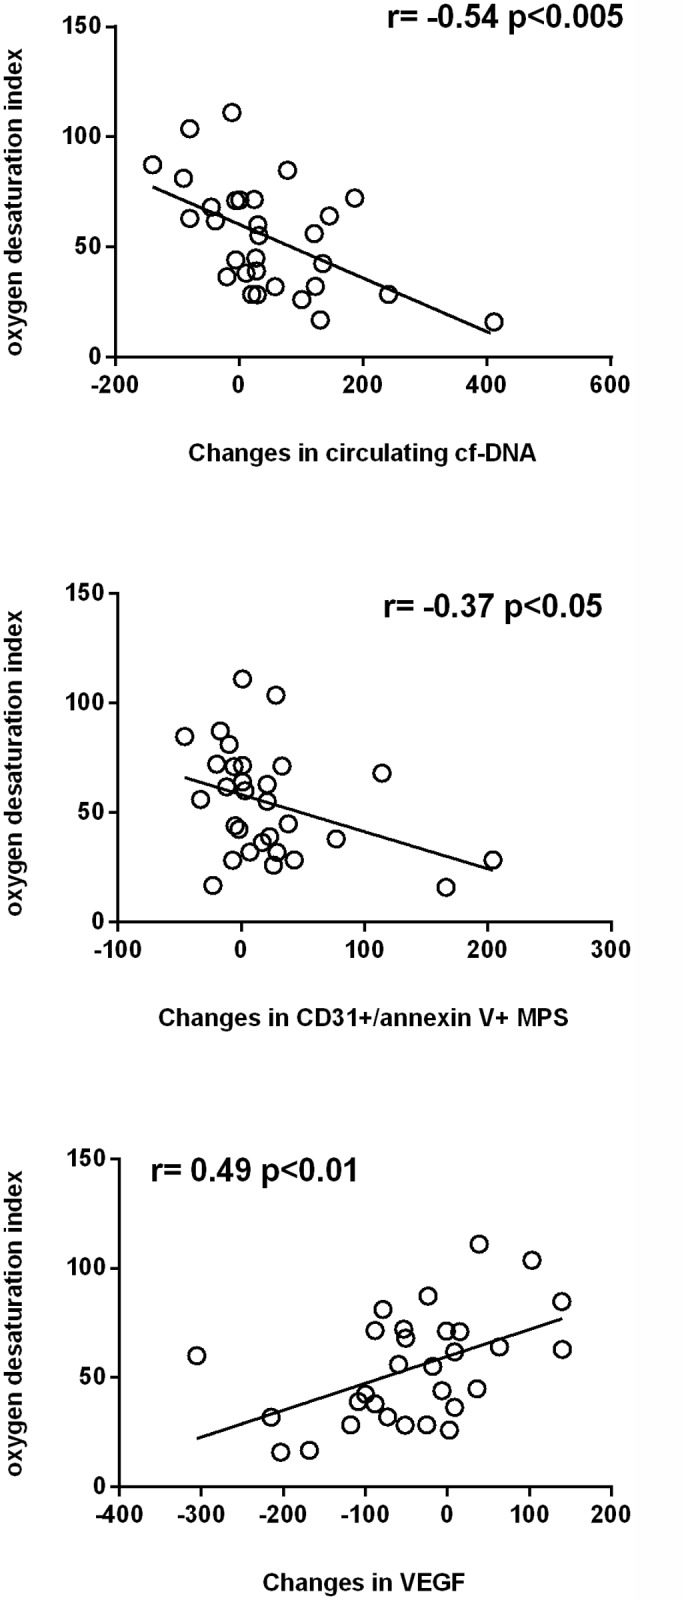
Relationship among the severity of the disease measured according to the oxygen desaturation index, and changes from baseline in circulating cf-DNA, CD31+/annexin V+ MPs and vascular endothelial growth factor (VEGF).